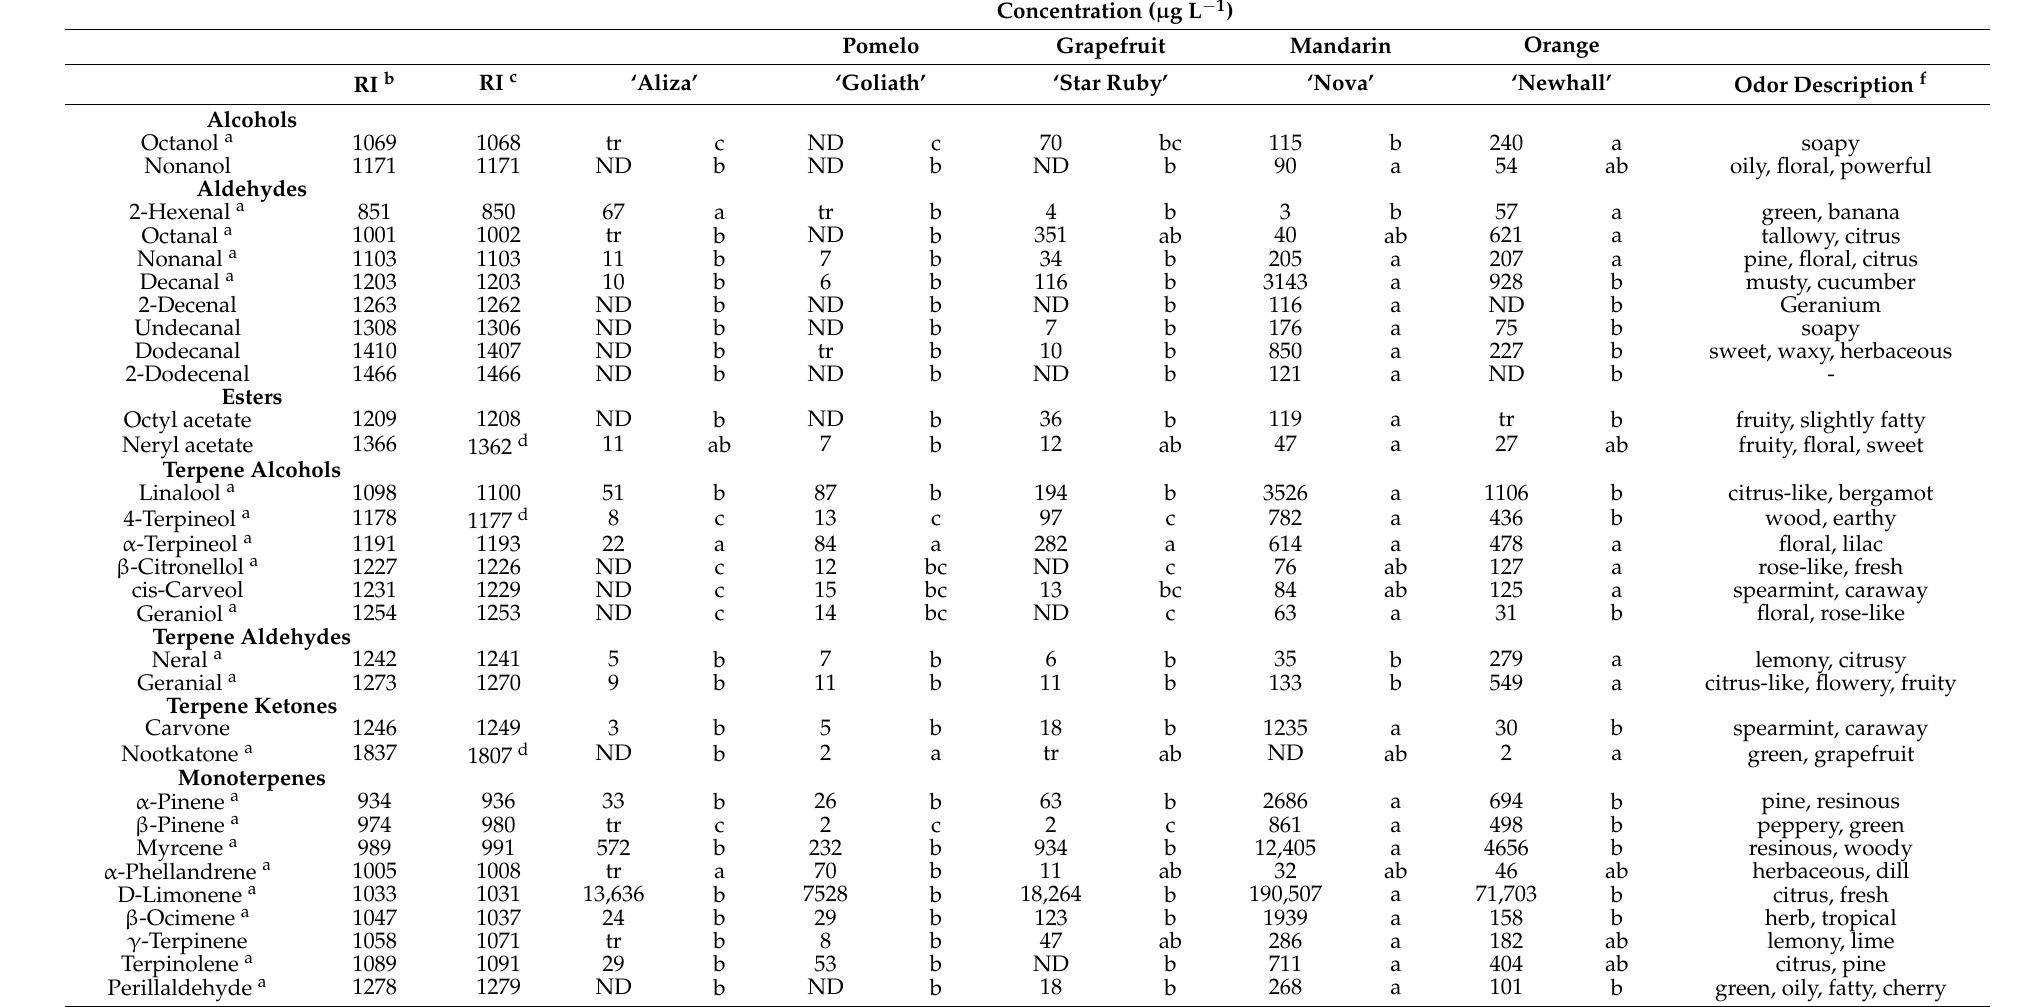
Table 2. Aroma volatile concentrations in the juices of ‘Aliza’, pomelo, mandarin, orange and